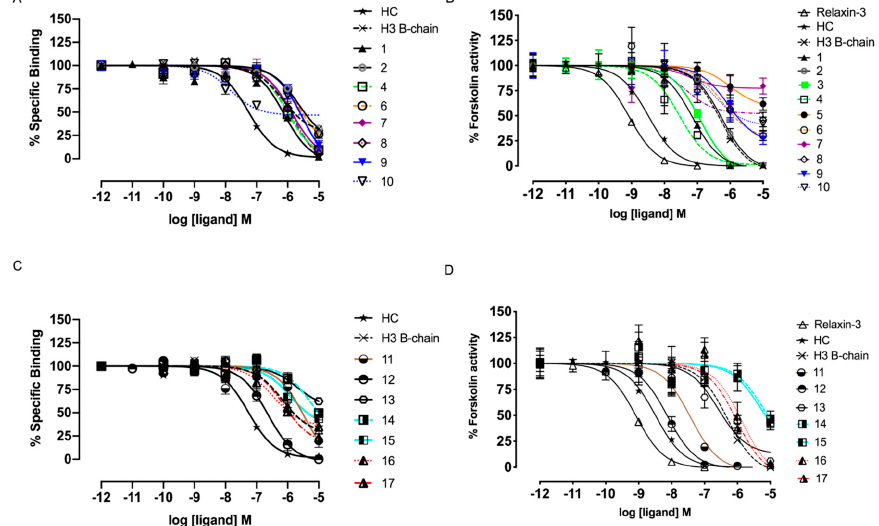
Figure 3. Binding affinity and potency of relaxin-3 agonist analogues at RXFP3. ( A , C ) illustrate the binding of the Aib and stapled analogues, respectively. ( B , D ) show the potency of Aib containing and stapled analogues, respectively. Data are shown as mean ± SEM of triplicate points from a minimum of three independent experiments. HC represents Ac-R3B10-27 [13/17 HC].